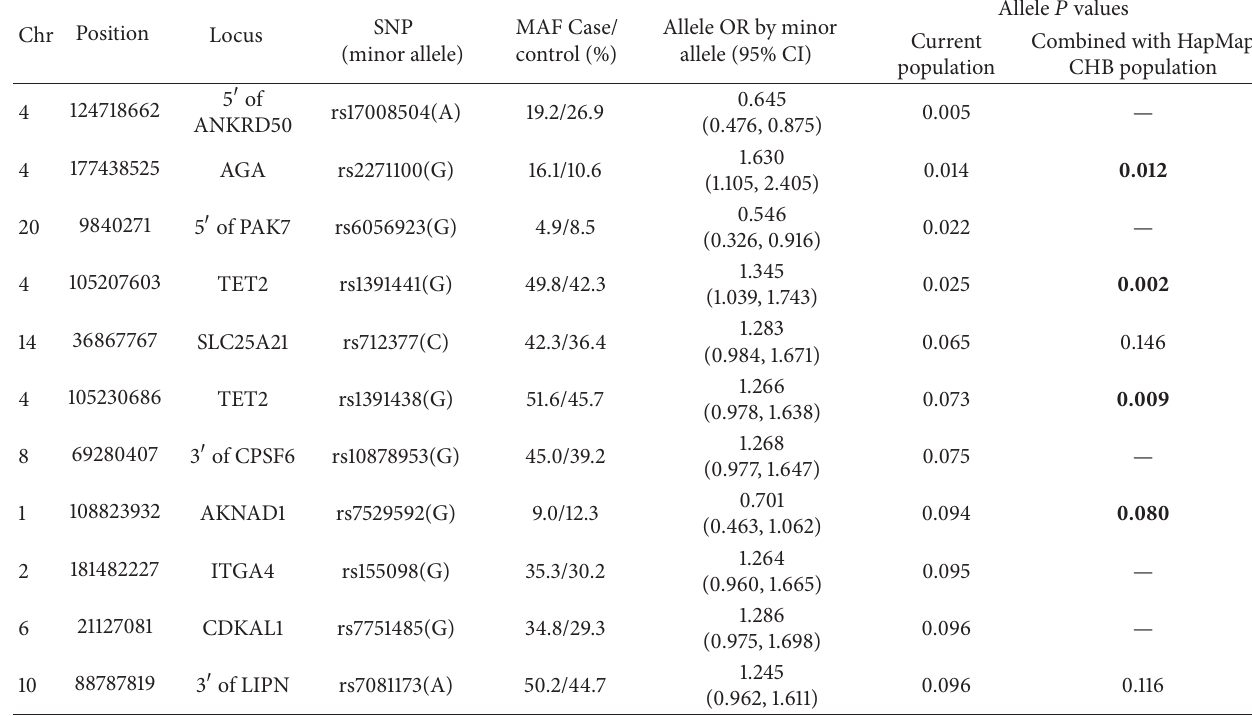
Table 1: Allelic association analyses of the positive trans -eSNPs of ATG5 in